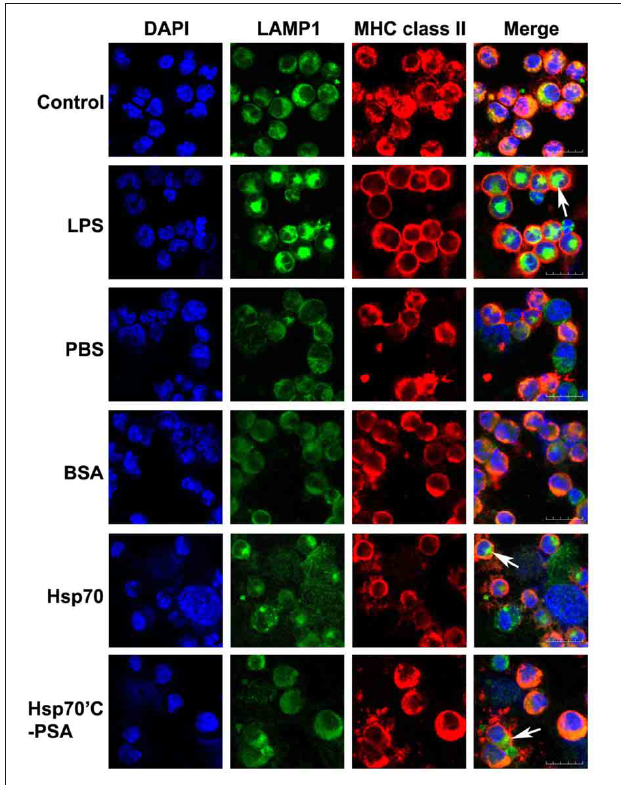
FIGURE 1 | Irradiated-CT26/PSA cells cause BM-DC maturation in the presence of rHSPs. BM-DCs (1 . 5 × 10 6 in 1ml) were incubated with medium alone (control) or LPS (10 μ g/ml) or were cocultured with irradiated-CT26/PSA cells (1 . 5 × 10 6 in 1ml) in PBS or 10 μ g/ml of